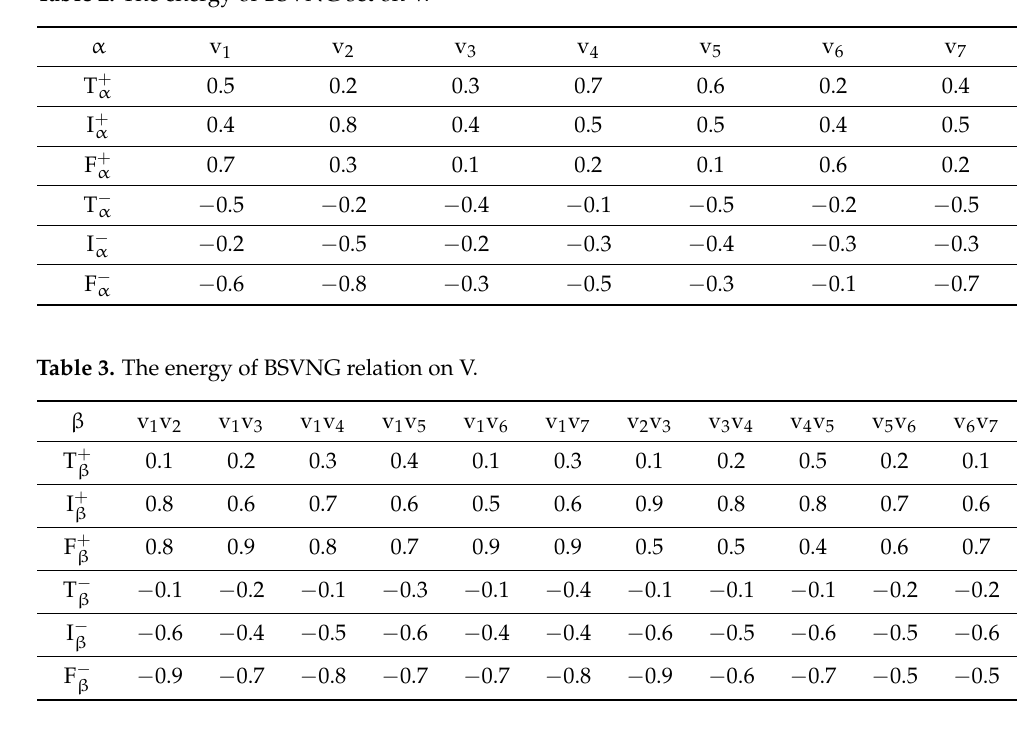
Figure 1. The energy of a bipolar single-valued neutrosophic graph. Table 2. The energy of BSVNG set on V.